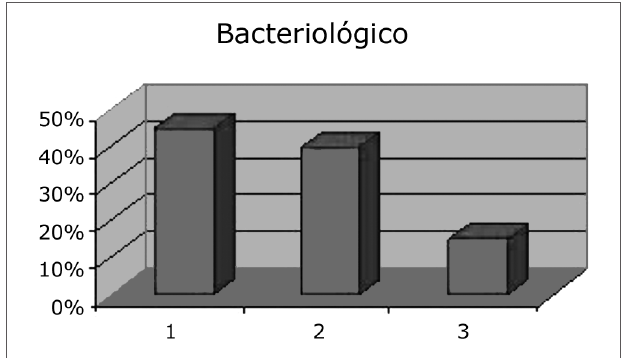
Tabela 1. Grau de mineralização do esmalte antes e após a disjun- ção maxilar.